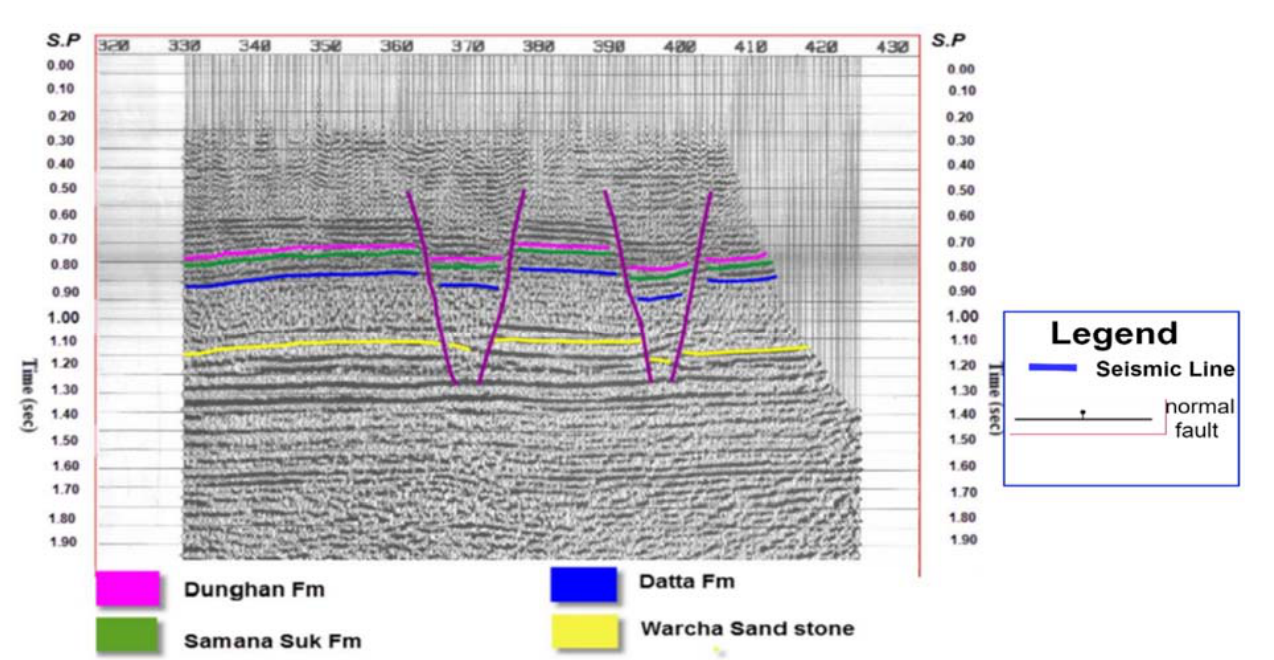
Figure 4. Marked seismic horizons of 875-KBR-221 line.